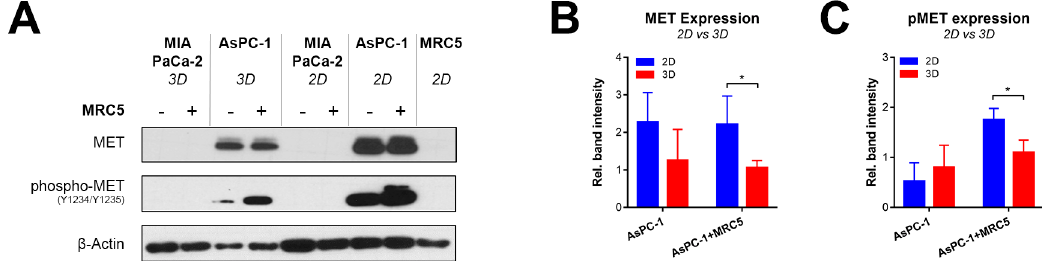
Figure 2. High HGF–MET signaling activity was detected in AsPC-1-based spheroids, but not in MIA PaCa-2-based spheroids. ( A ) Immunoblots depicting the expression levels of MET, phospho-MET (Y1234 / 1235), and β -actin (loading control) in 2D and 3D cultures composed of AsPC-1, AsPC-1 + MRC5, MIA PaCa-2, and MIA PaCa-2 + MRC5 cells. ( B , C ) Comparative protein band quantification of MET expression (B) and MET phosphorylation (C) in 2D and 3D cultures composed of AsPC-1 and AsPC-1 + MRC5 cells. Data represent the mean + SD from four technical repeats and were normalized to their respective loading controls. Statistical significance is indicated as * p < 0.05.